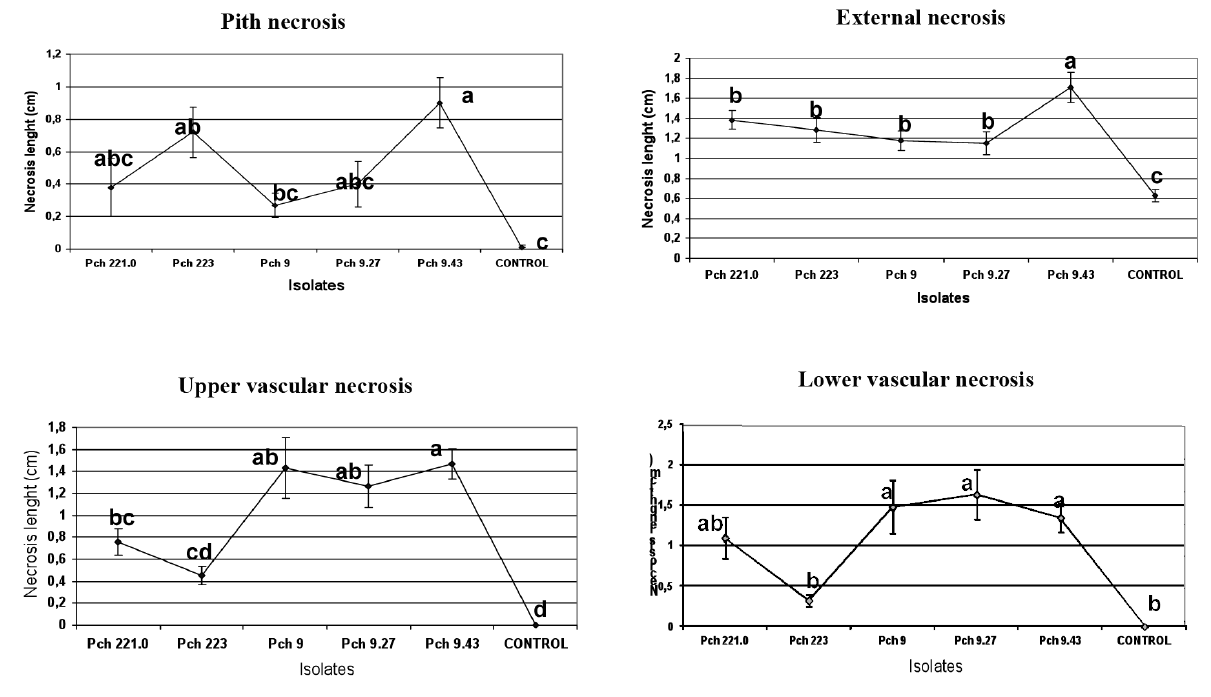
Figure 4. Necrosis length produced by the P. chlamydospora isolates selected as representatives of the main morphotypes recognized after artificial inoculation of grapevine shoots. Length values are expressed as means of 30 data. Bars represent standard deviations. Different letters refer to LSD test significance ( P <0.05).